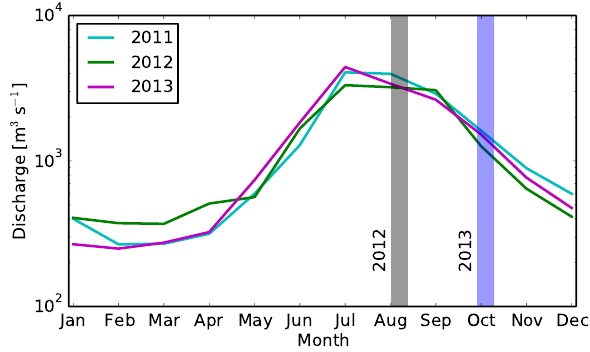
Month10 2 Jan Feb Mar Apr May Jun Jul Aug Sep Oct Nov Dec Figure 2. Average monthly water discharge of the Kosi River (measured at the Kosi barrage, Bhimnagar, during three successive years). Gray and blue shades indicate our measurements (source: Investigation and Research Division, Kosi project,